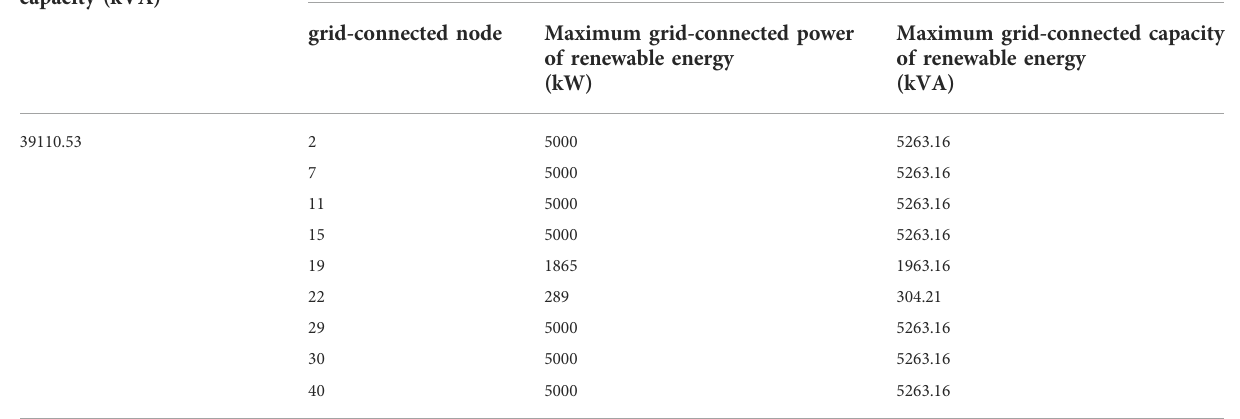
TABLE 4 The renewable energy hosting capacity and the maximum grid-connected capacity of each grid-connected